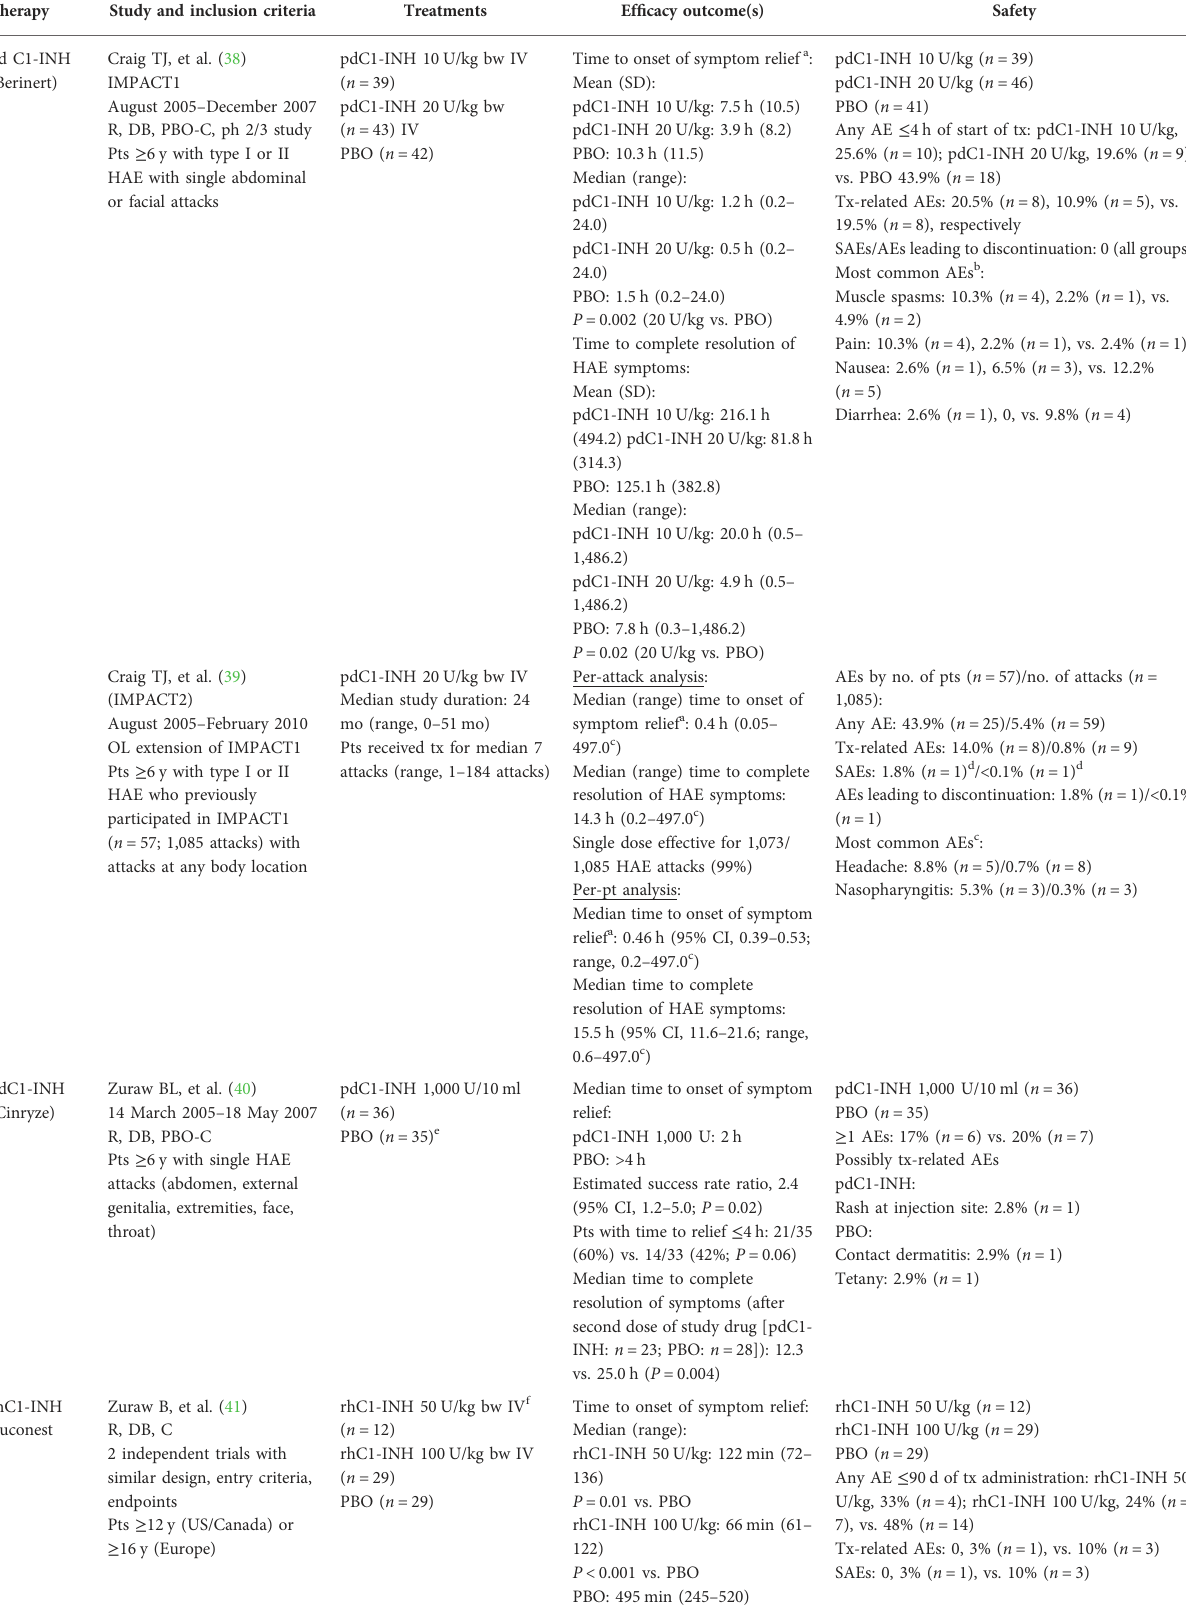
TABLE 2 Summary of clinical trials of C1-INH replacement therapy as on-demand treatment for HAE attacks. Therapy Study and inclusion criteria